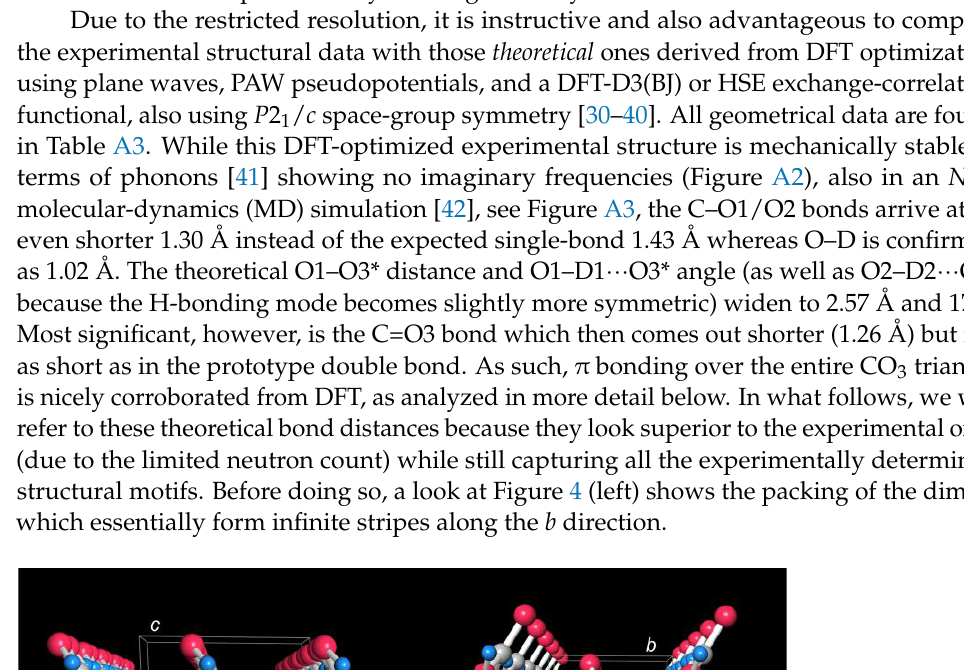
Figure 3. Mesomerism of carbonic acid. Covalent ( left ) and ionic ( right ) mesomeric structures contribute to the shape of carbonic acid; the latter ionic ones widen the “double” and shorten the “single” bond, as found both in experiment and theory.